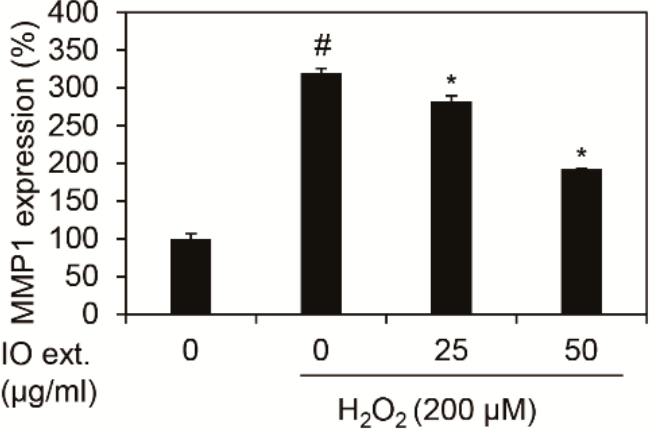
Figure 2. Effects of extracts of Inonotus obliquus on MMP1 mRNA expression in human dermal fibroblasts. Inonotus obliquus extracts decreased MMP1 mRNA expression against H 2 O 2 treatment at 24 h. MMP1 mRNA expression were normalized to β -actin. The results are expressed as the mean ± S.D. from triplicate experiments. # p < 0.05 compared with non-treated cells. * p < 0.05 compared with 200 μ M H 2 O 2 -treated cells.